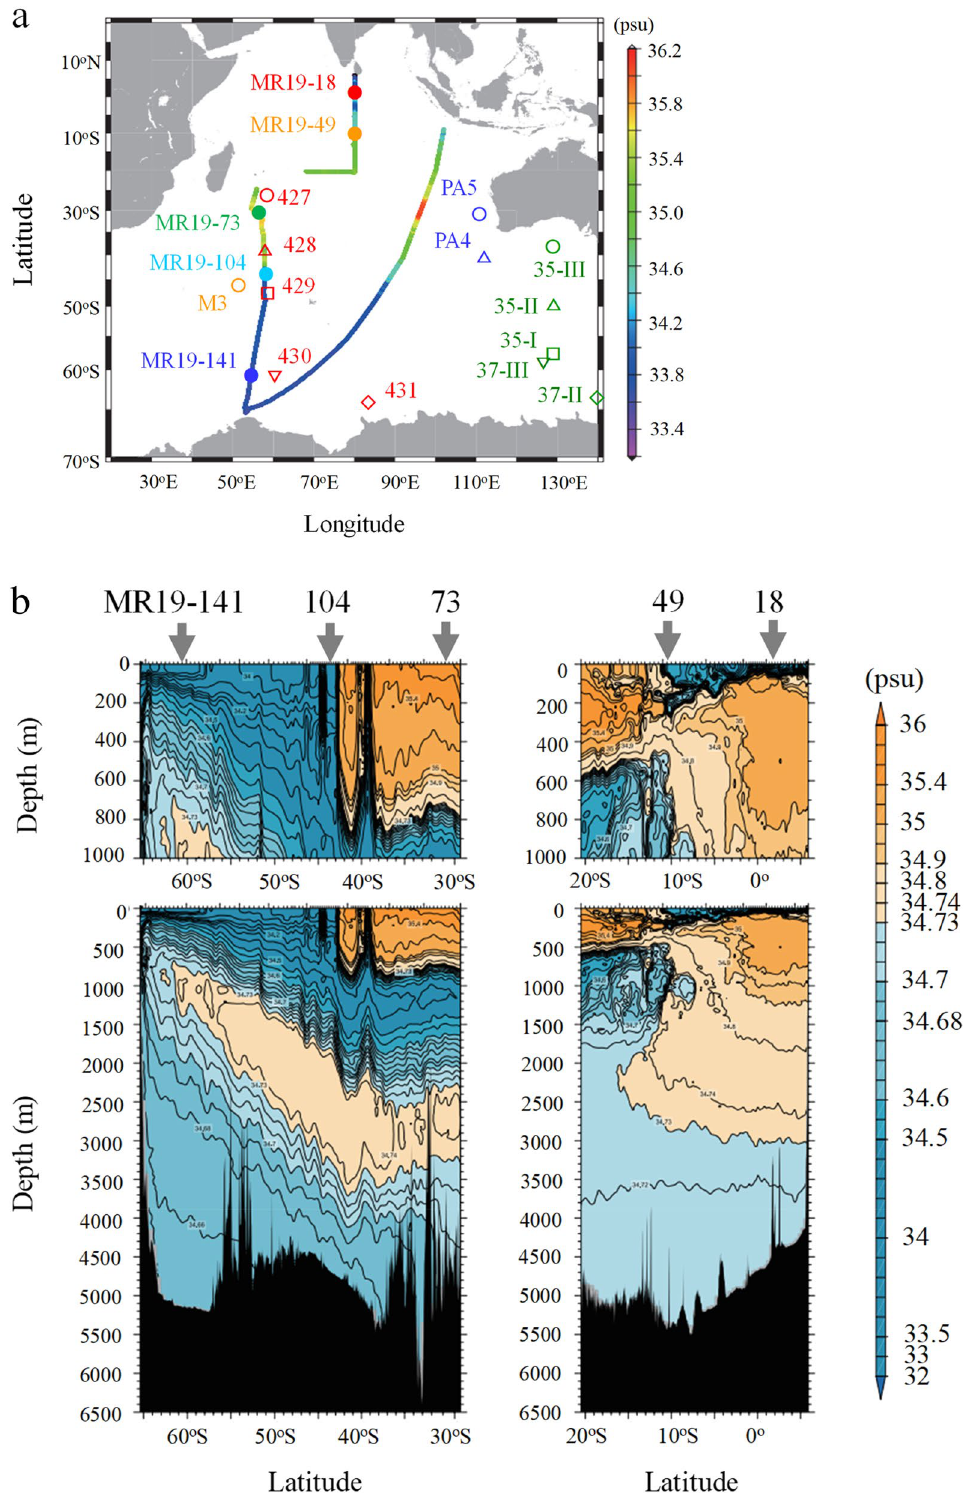
Figure 1. ( a ) Surface salinity along with sampling sites of the MR19-18–141 seawaters in the Indian and Southern Oceans, with key sites from previous studies (sites 35 and 37 in 1968–1969 20 , 427–431 in 1977– 1978 24,25 , PA4 and PA5 in 1996 22 , and M3 in 2005 19 ), and cross-sectional views of b) salinity and c) dissolved oxygen, along the R/V Mirai expedition route 29 . The figures were drawn using the Generic Mapping Tools ver. 4.1.1 (https:// www. gener ic- mappi ng- tools.